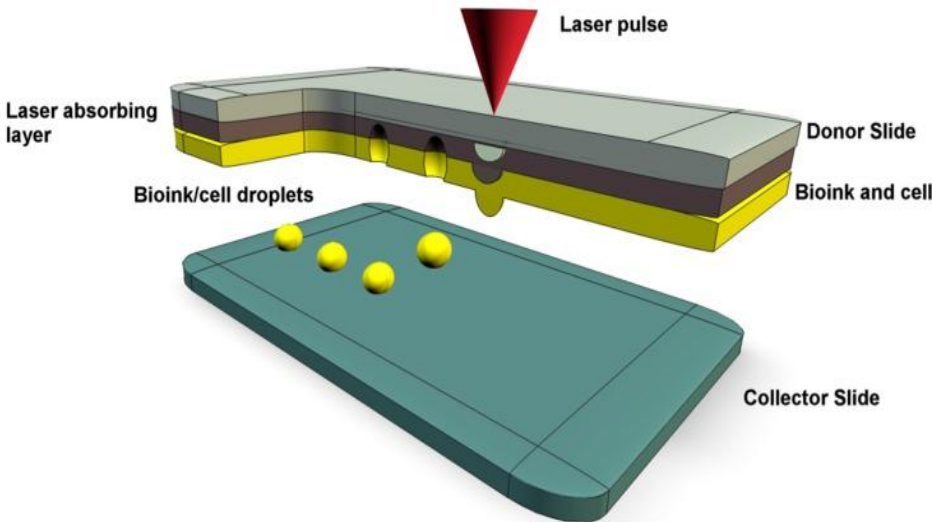
Figure 3. A representation of laser-assisted bioprinting with bioink droplets deposited by laser pulses onto a collector slide [38] . Table 1. Bioprinting techniques.